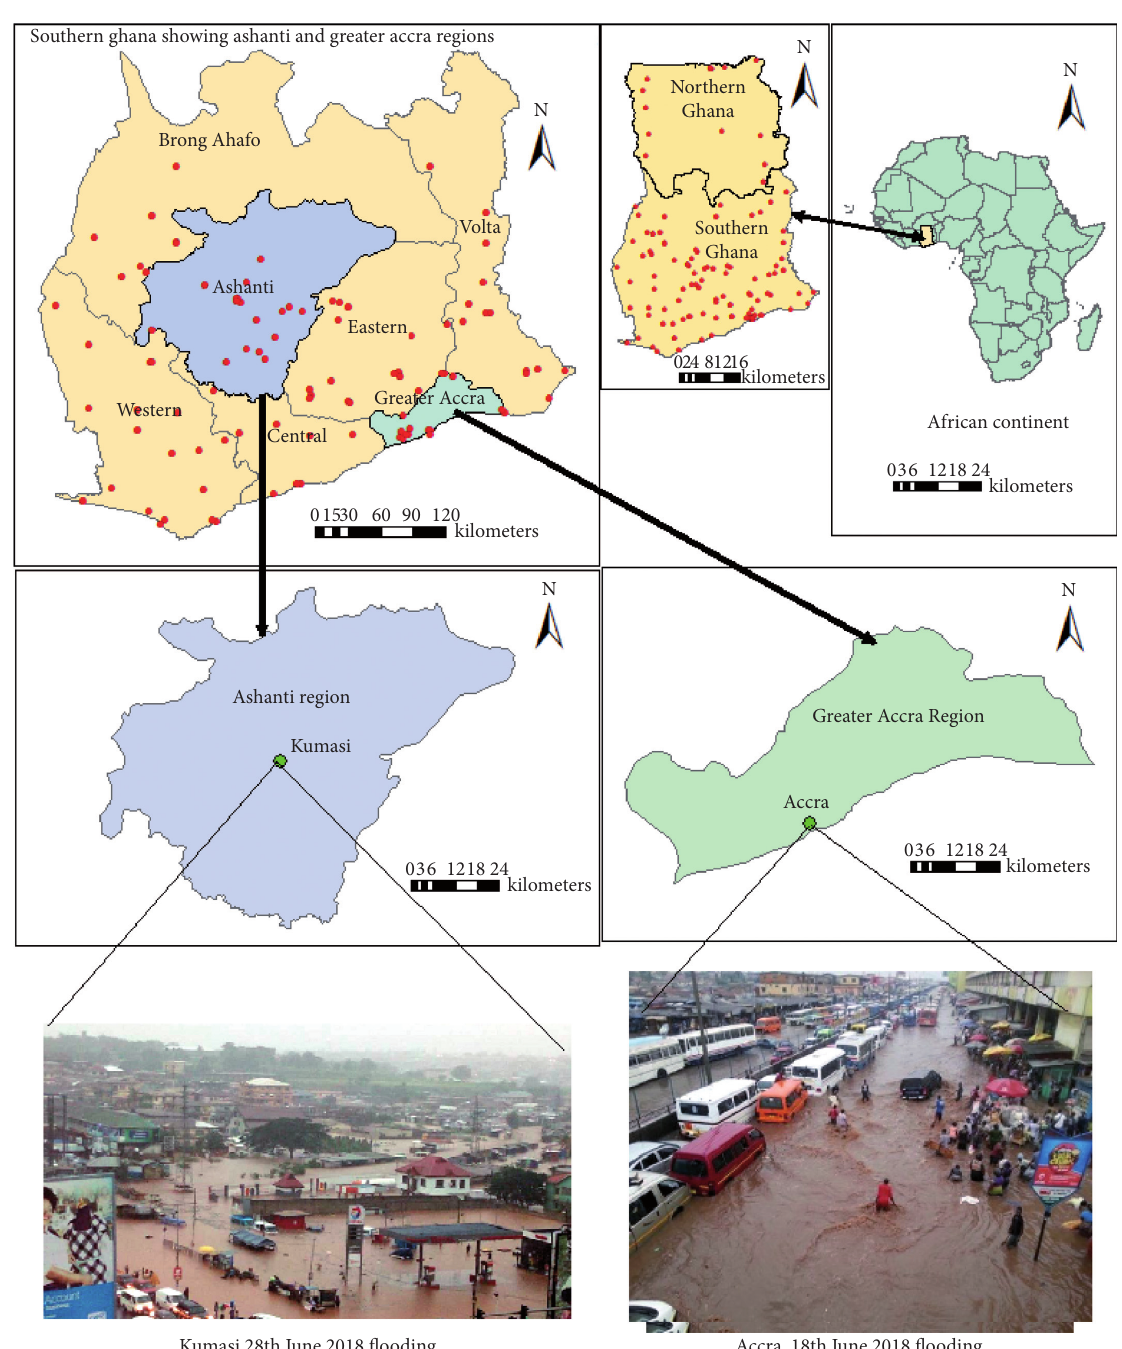
Figure 1: Map of study area. Location of cases A and B flood events and the distribution of the Ghana Meteorological Agency’s weather observation stations (red